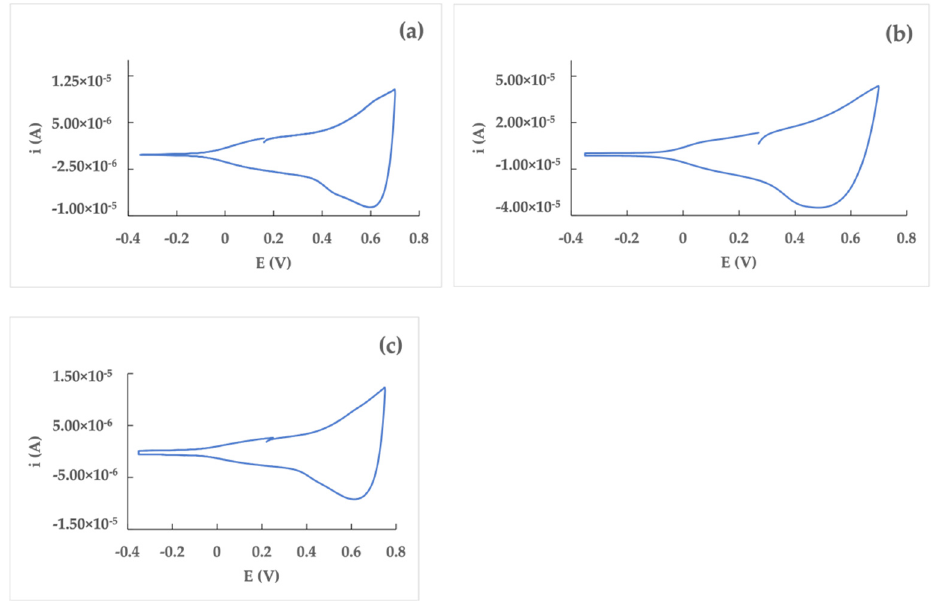
Figure 3. Cyclic voltammetry characterization of poly(dTT − bT) on the Pt ( a ), GC ( b ), and Au ( c ) electrode surfaces. 0.1 M TEAPF 6 /CH 2 Cl 2 solvent system. Potential scan rate: 100 mV s − 1 .